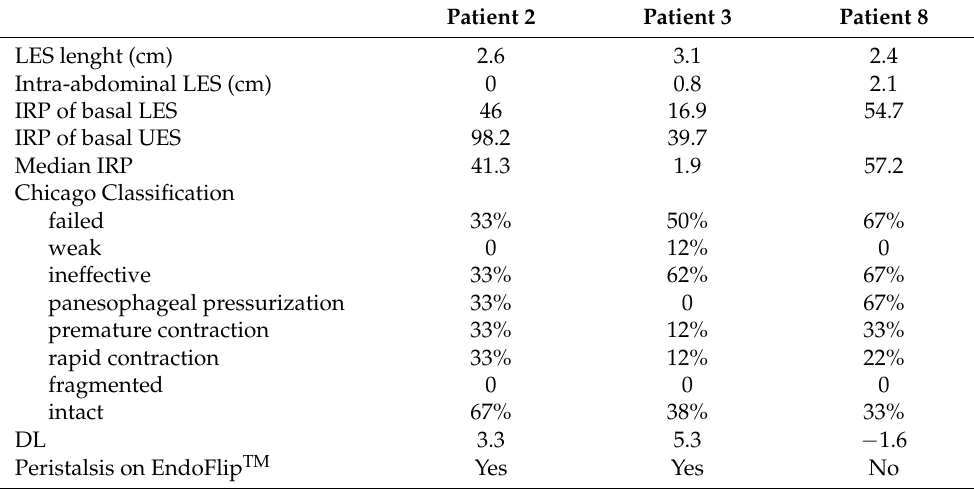
Table 4. HRM findings in three patients of the reported series.